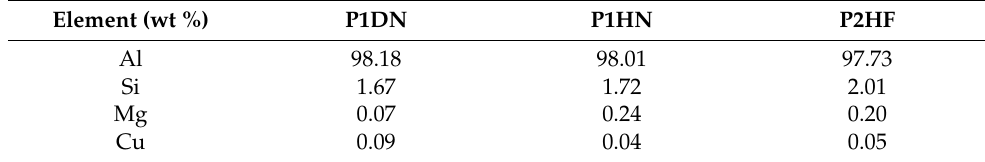
Table 6. EDS results of the three